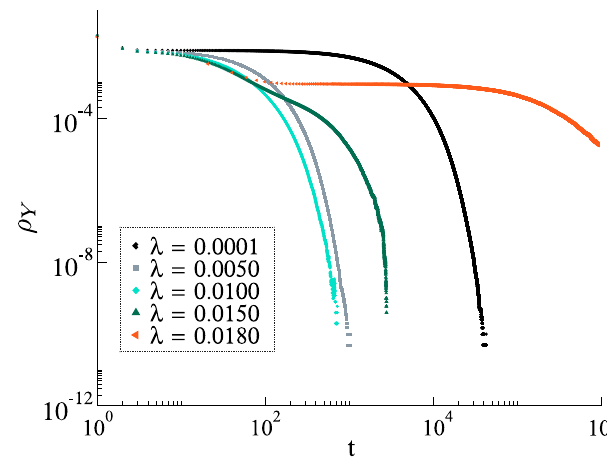
Fig. 5 Critical point estimations of uncorrelated power-law networks. We plot λ c as a function of N and for different values of γ and α , considering δ = 1.